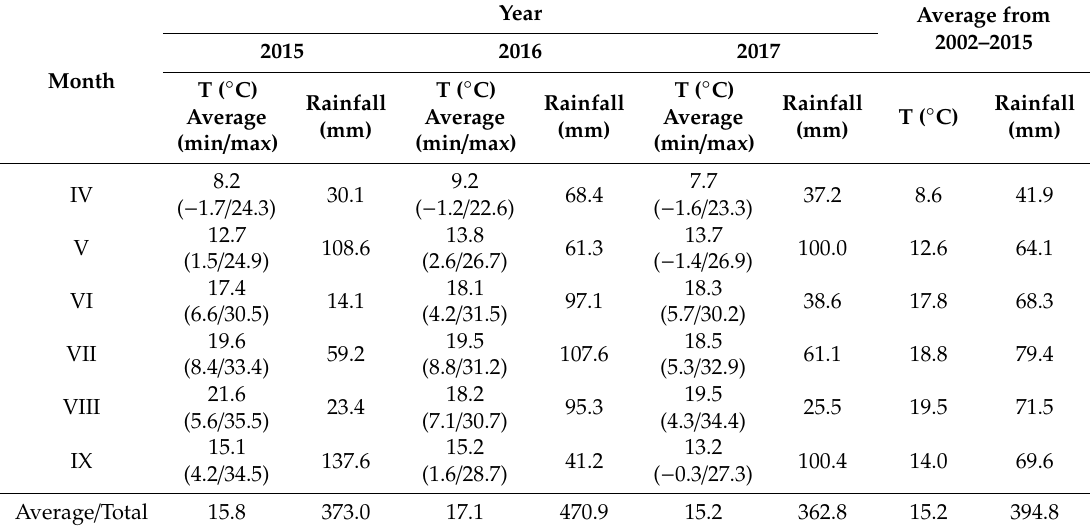
Table 2. Conditions during the growing seasons in bean variety Oczko cultivation in